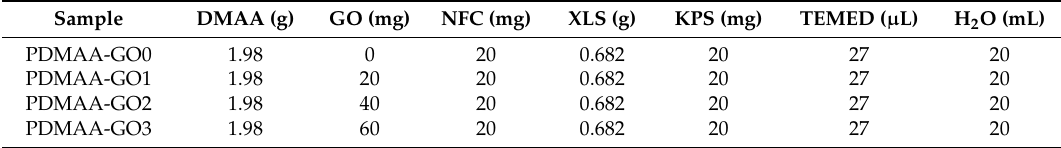
Table 1. The compositions of the poly N , N -dimethylacrylamide (PDMAA) hydrogels.